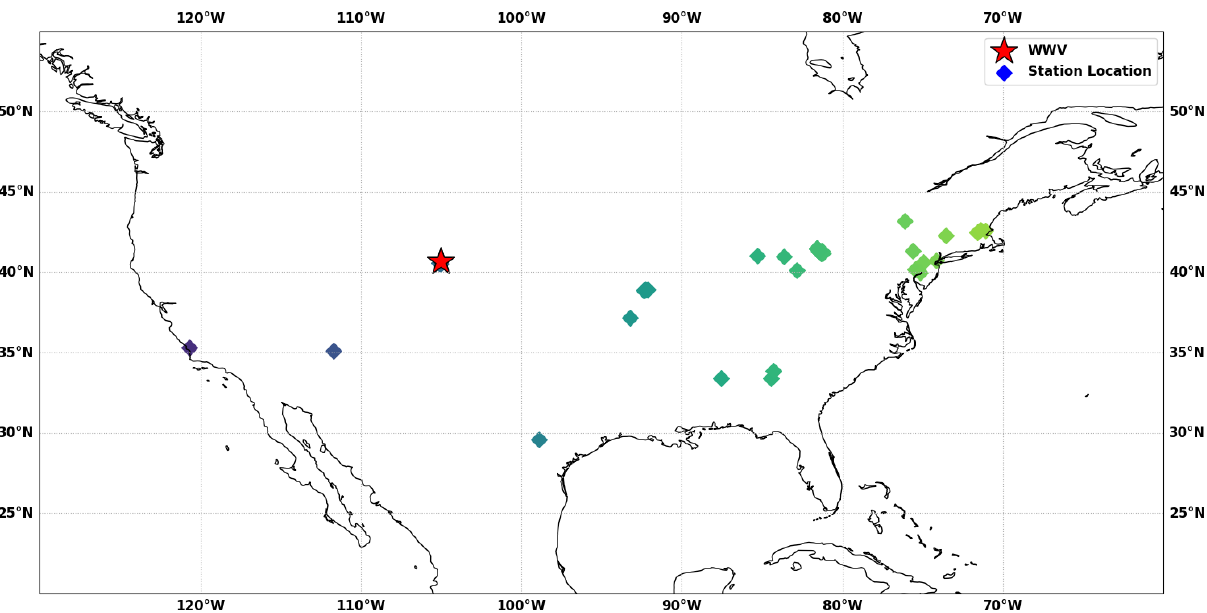
Figure 3. A map of currently deployed Grape stations in the United States. Per Table A1, some international stations are not shown. Scatter points mark the locations of each station. Points are color-coded by station longitude.